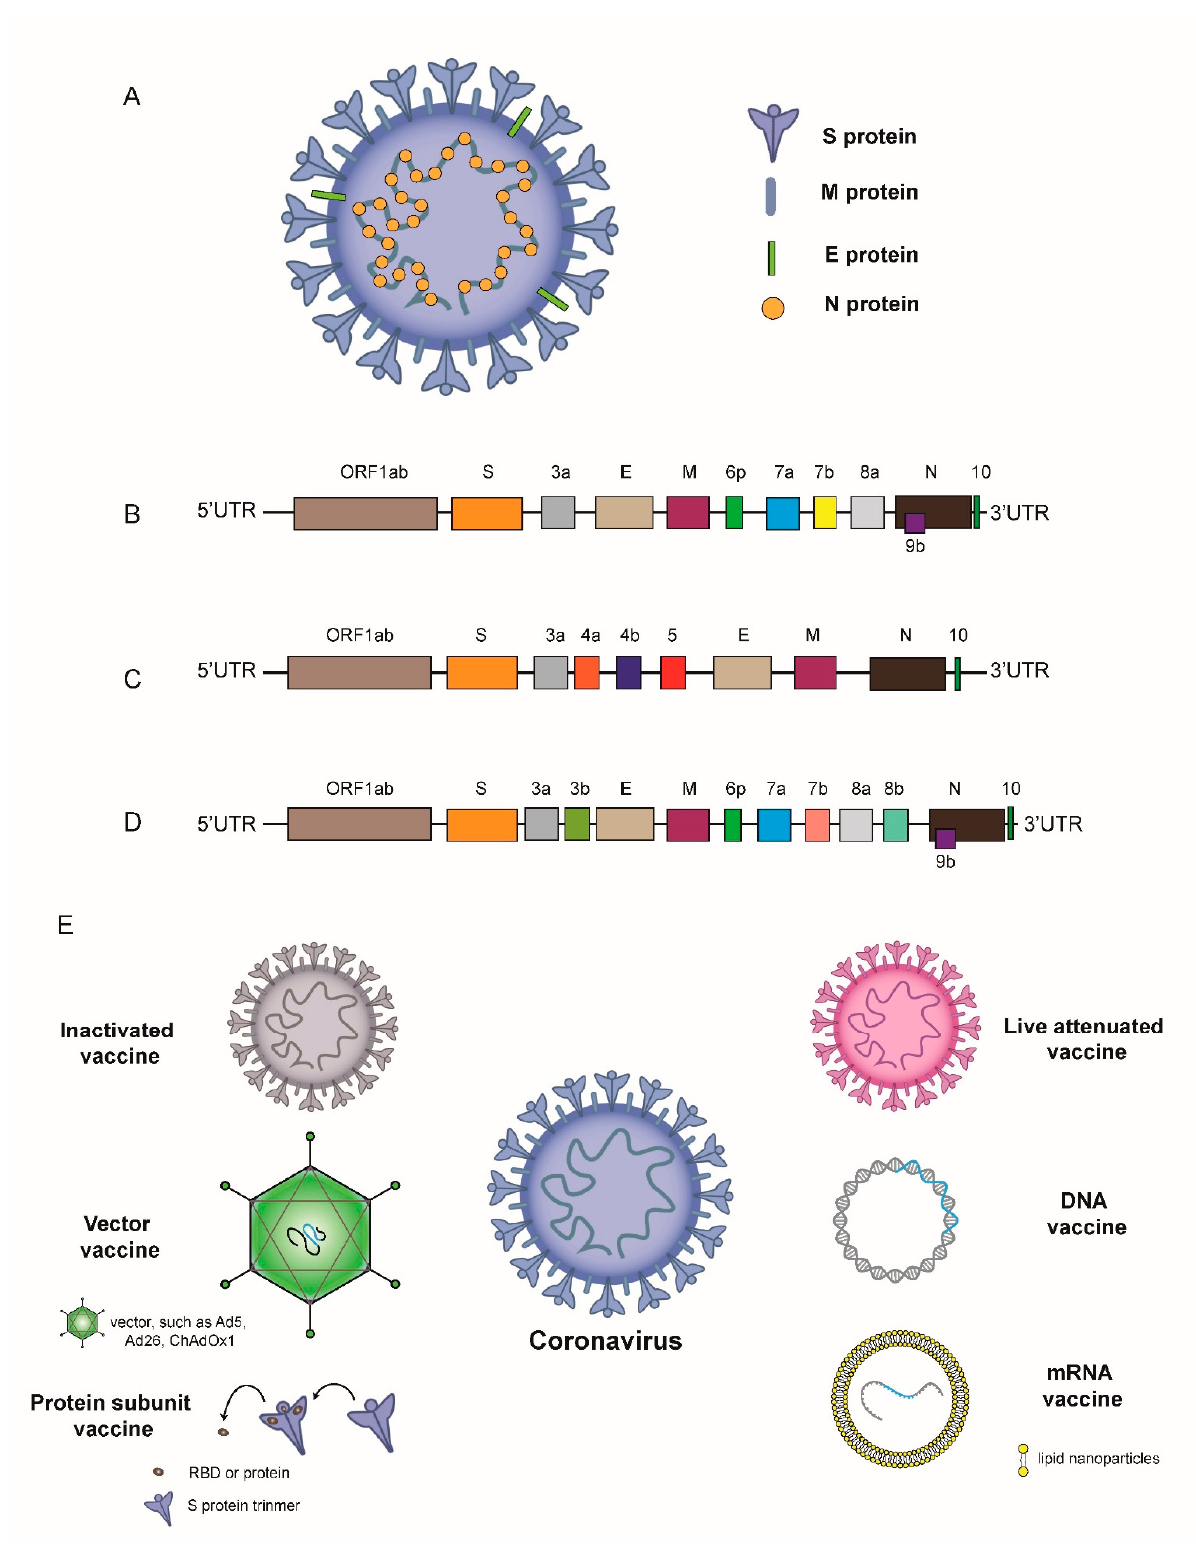
Figure 1. ( A ) Structure of coronavirus; ( B – D ) the schematic genomic structure of coronaviruses: ( B ) SARS-CoV-2; ( C ) MERS-CoV; ( D ) SARS-CoV; ( E ) Schematic diagram of different types of coronavirus vaccines. Current research on coronavirus disease 2019 (COVID-19) suggests that the earliest outbreak began on 1 November 2019 [7]. Shortly thereafter, SARS-CoV-2 was identified as